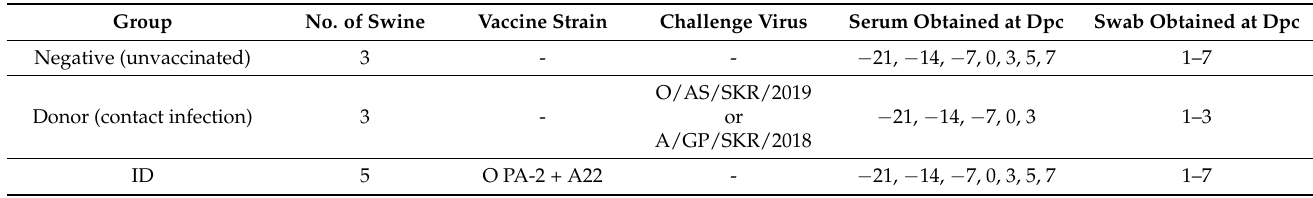
Table 2. Experimental designs of intradermal vaccination against FMD